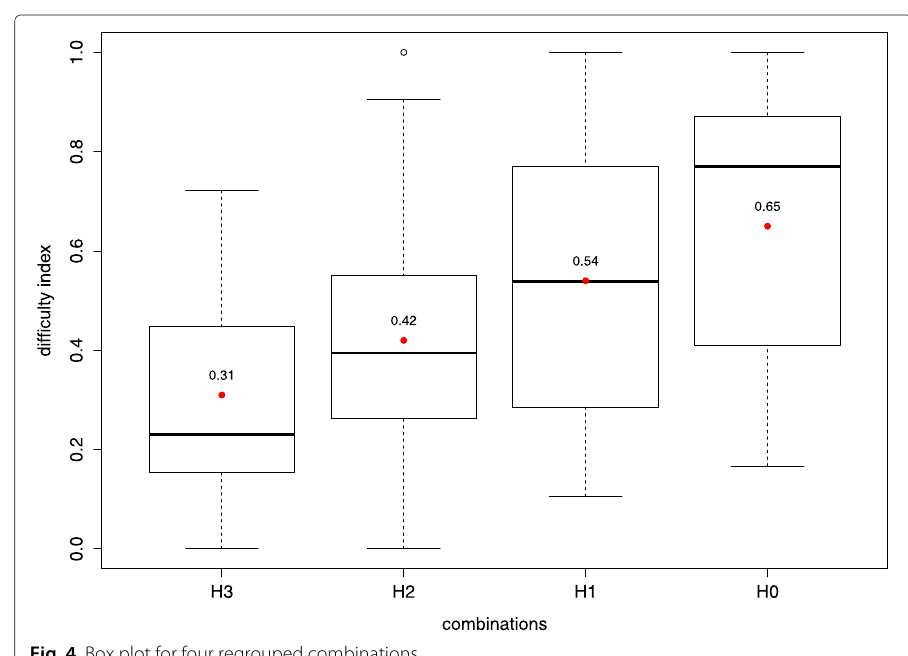
Fig. 4 Box plot for four regrouped combinations The correlation between the test taker scores in the experiment and their latest exam scores (Table 3) shows that the automatically generated question items can measure the proficiency of the test takers in every class except for one where the correlation is negative. Thus, we have an affirmative answer to our research question. However, the correlation is not so strong. Further investigation with more participants is necessary to reinforce the answer to our research question.